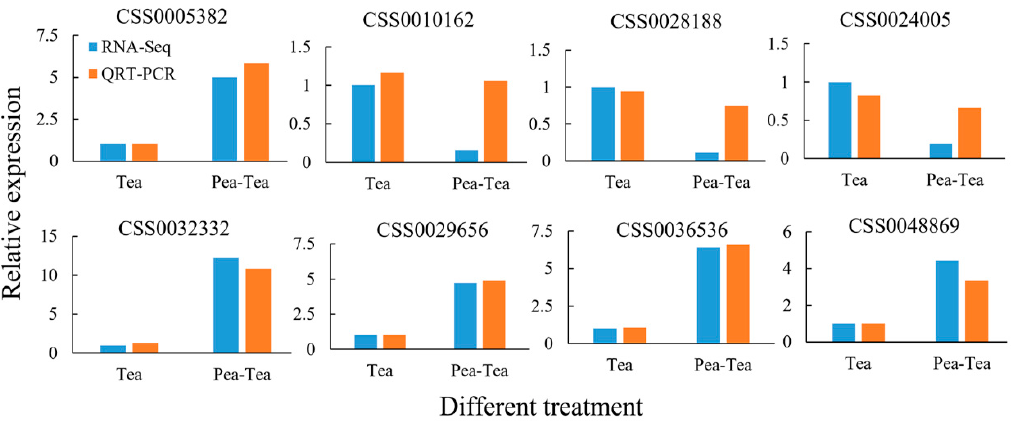
Figure 3. Quantitative real-time PCR verification of differentially expressed genes. RNA-Seq indicates fold change of FPKM and QRT-PCR means relative expression of FPKM cDNA as calculated by 2 − ∆∆ CT